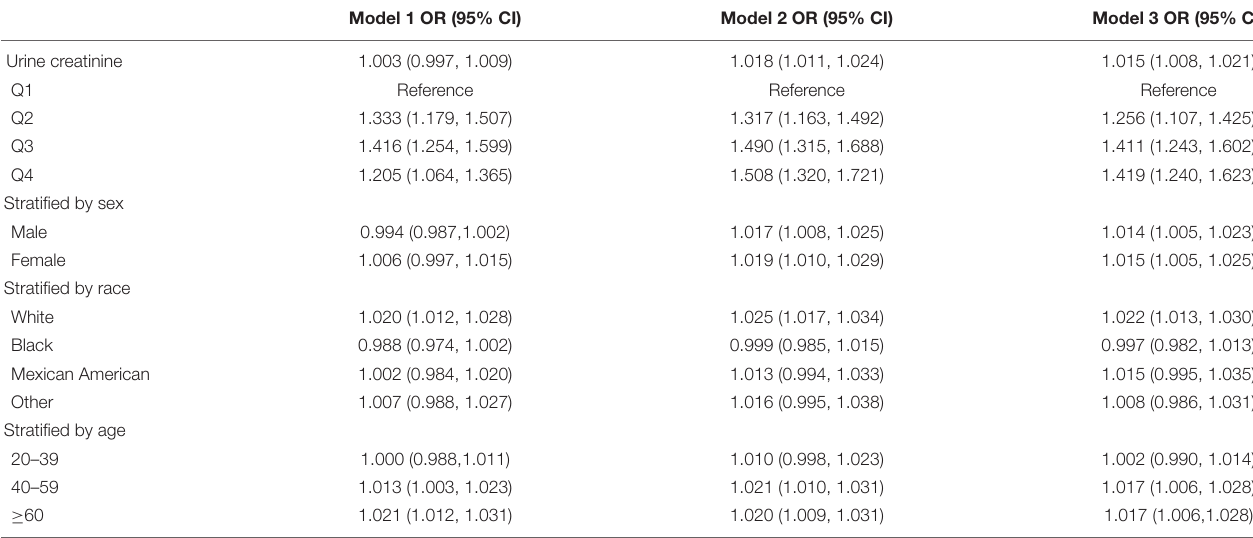
TABLE 3 | Analysis between UCR with kidney stone formation in different